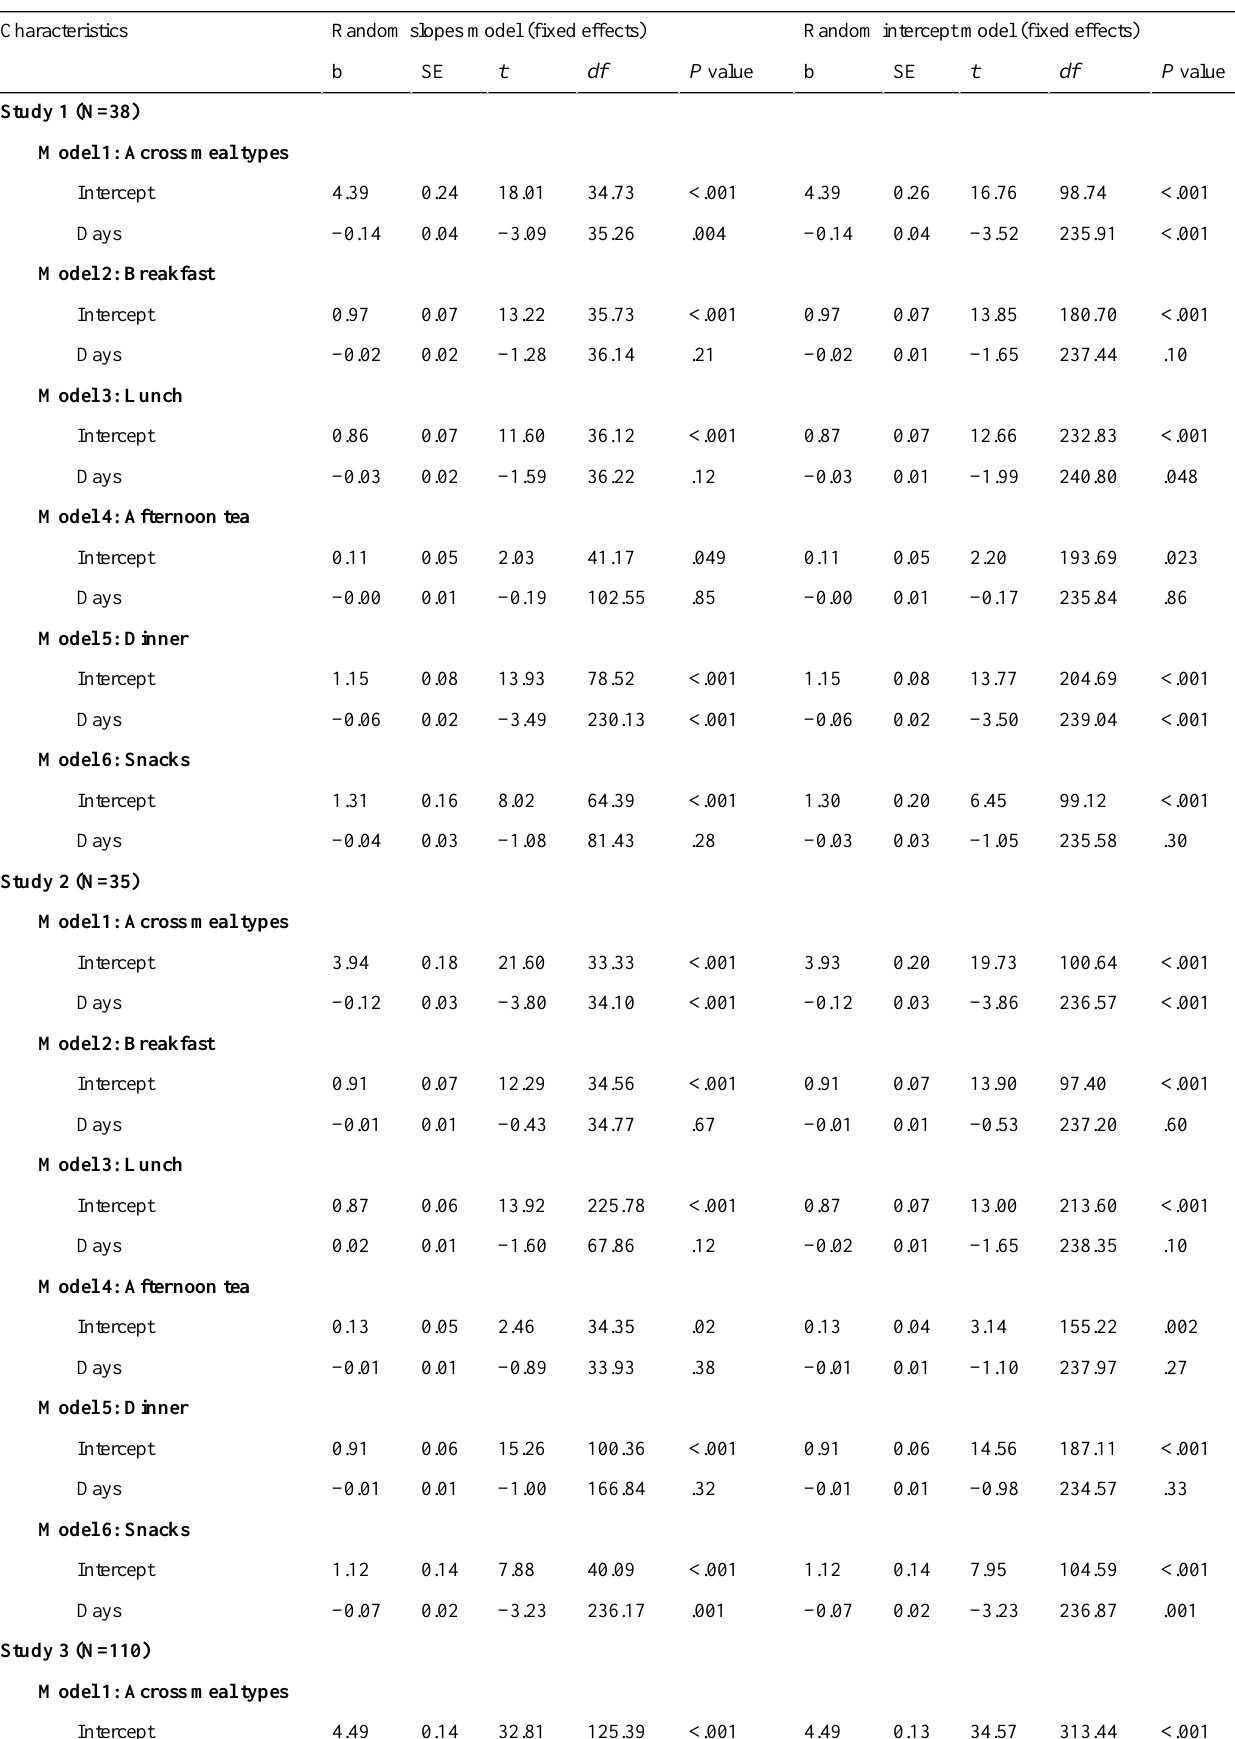
Table 2. Multilevel models for logging trajectories across the 8-day study period across all eating events and by meal types for studies 1, 2, and 3.